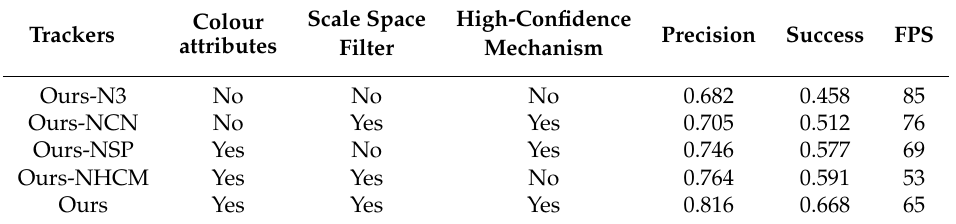
Table 2. The characteristics and comparison results of different versions of our propoach on OTB-13. Trackers